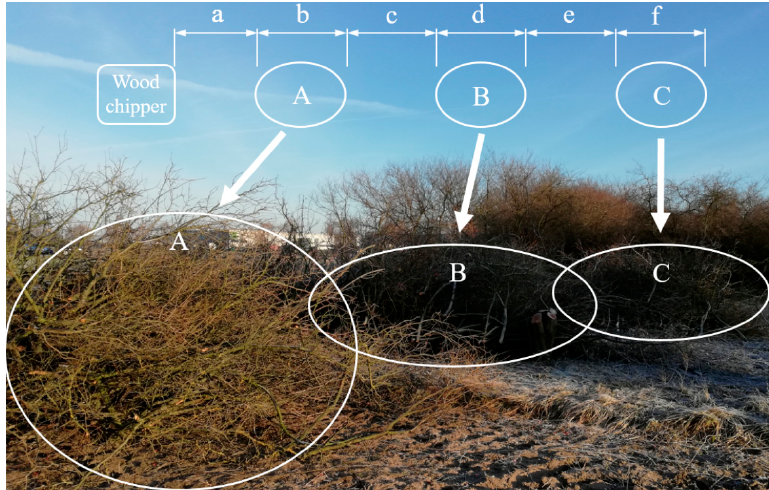
Figure 2. Arrangement of piles of branches relative to the chipper; distances: a–f = 3 m.